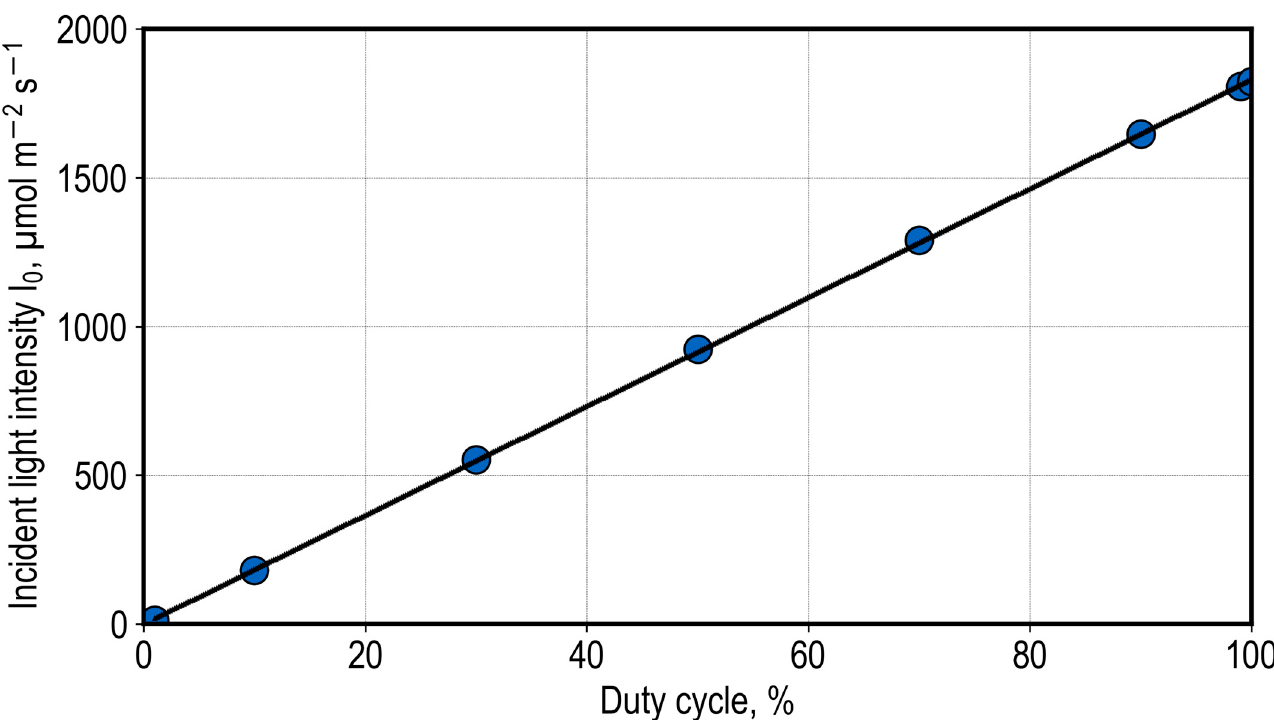
Figure A5. Incident light intensities measured at one reactor position of an illumination module as a function of selected dimming settings between 0 and 100%. Light intensities were measured in the range 400–700 nm (PAR).